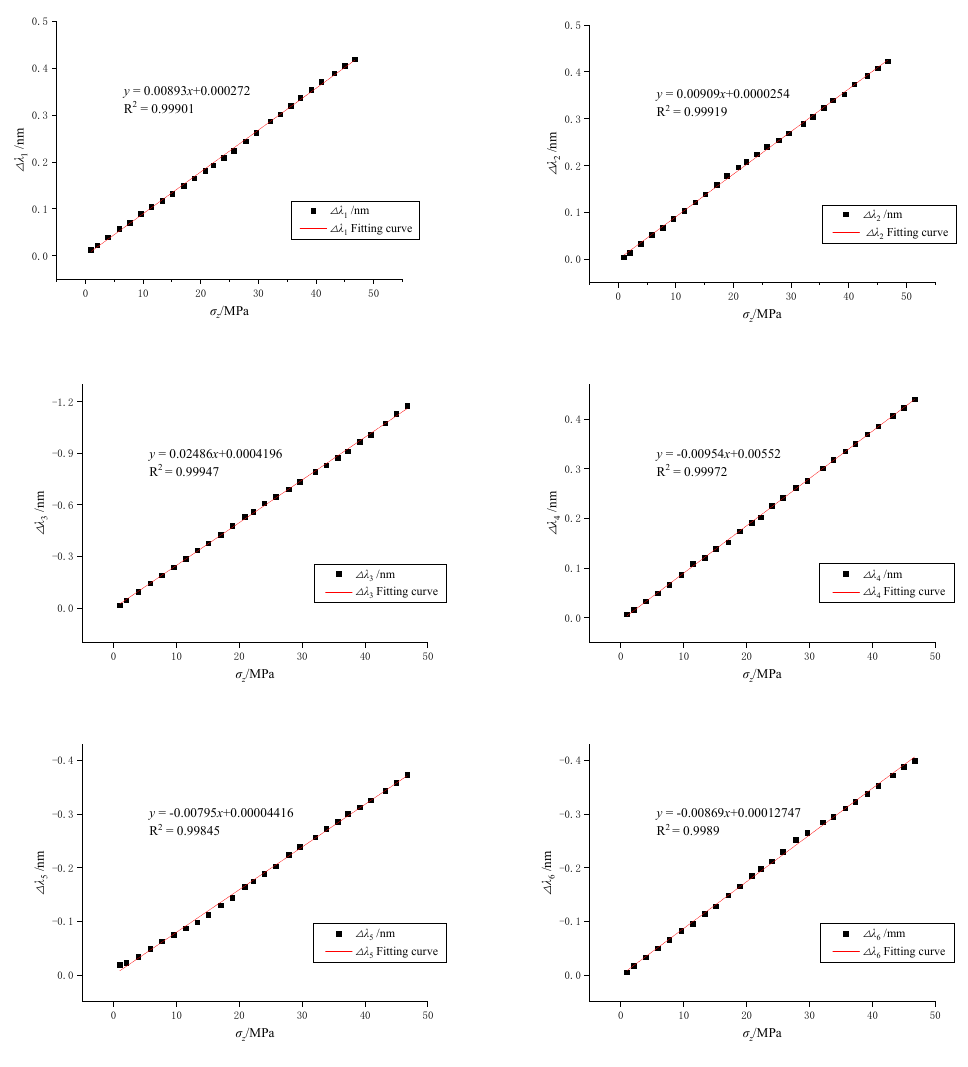
Figure 12. Variation of FBG wavelength with stress.